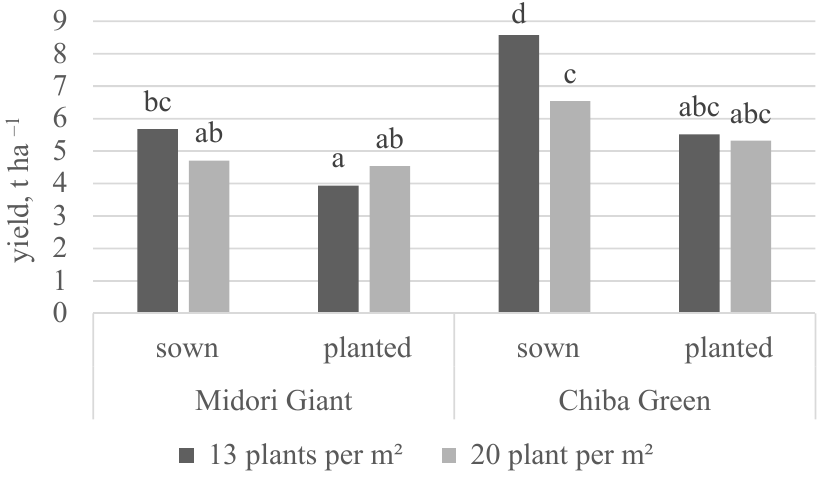
Figure 4. Vegetable soybean fresh pod yield in 2018, in Latvia. n = 2. Values marked by different letters have significant difference (Duncan’s criteria, p < 0.05).